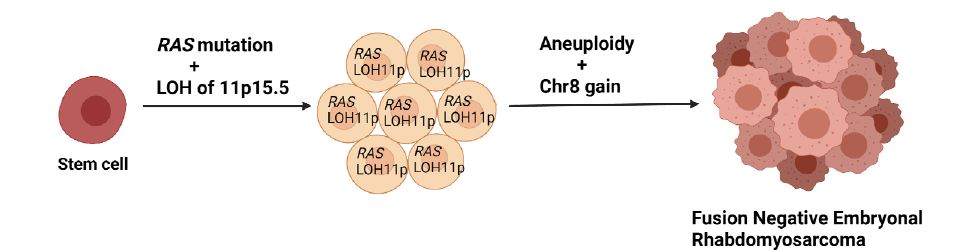
Figure 2. Proposed evolution of FN-RMS adapted from Chen et al.